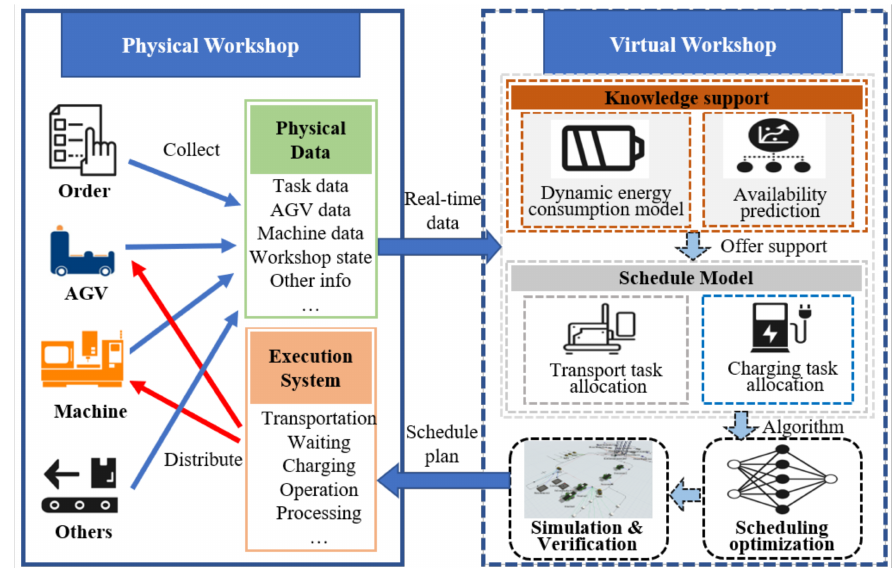
Figure 3. The framework of